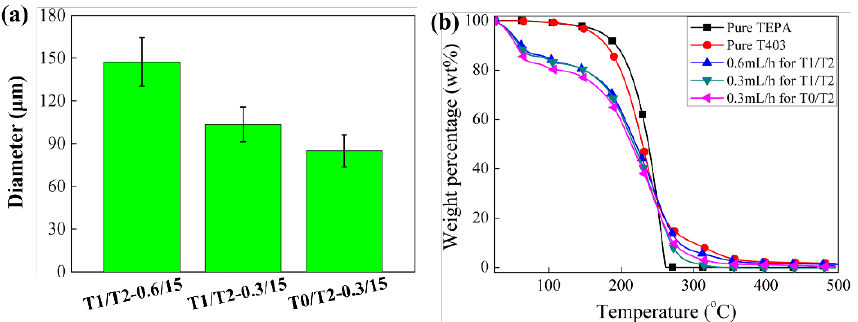
Figure 3. ( a ) Diameters of the synthesized polyamine microcapsules when different T-junctions and different feeding rates of the polyamine were adopted, and ( b ) TGA curves of pure tetraethylenepentamine (TEPA), pure T403, and the microcapsules with different sizes.